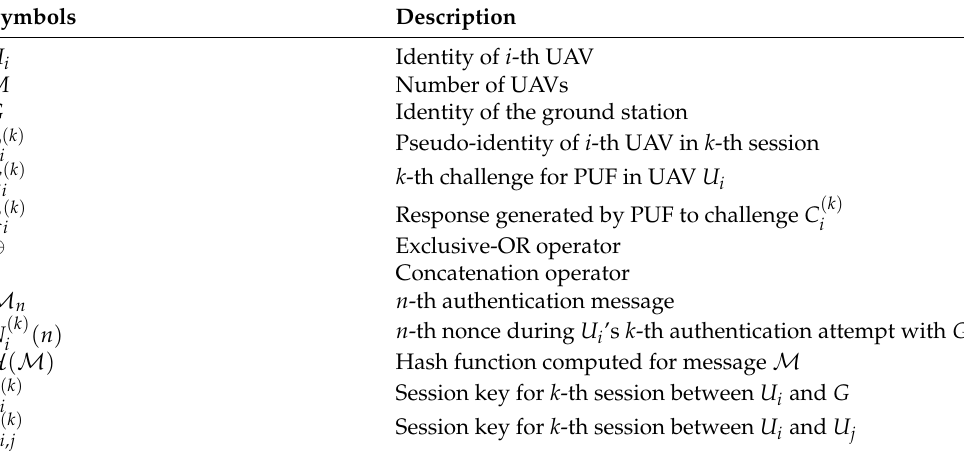
Table 2. Symbols and